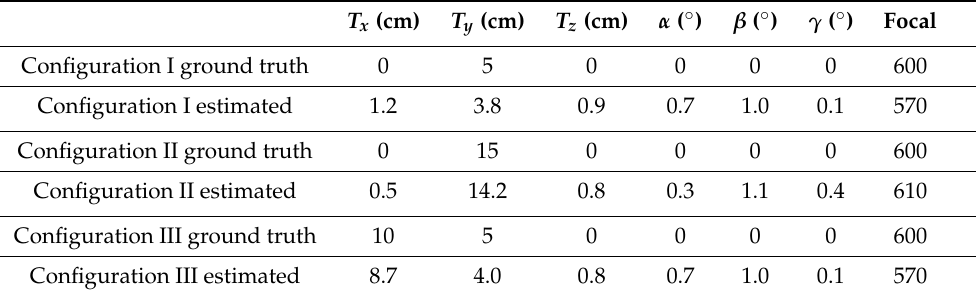
Table 3. Results obtained with our method for the three geometric